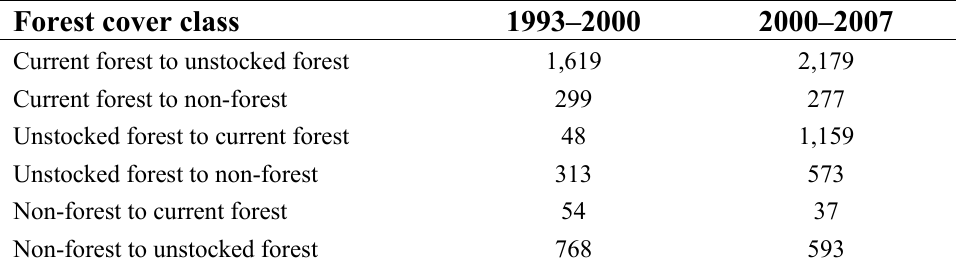
Table 6. Forest cover changes in km 2 (1993–2000 and 2000–2007).